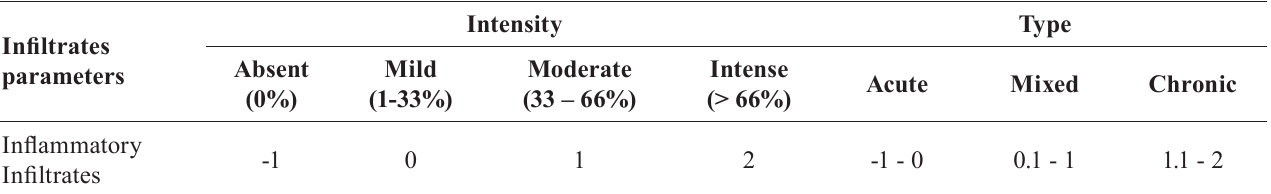
TABLE I - N umerical criteria for the classification of inflammatory parameters according to the type of cell found during